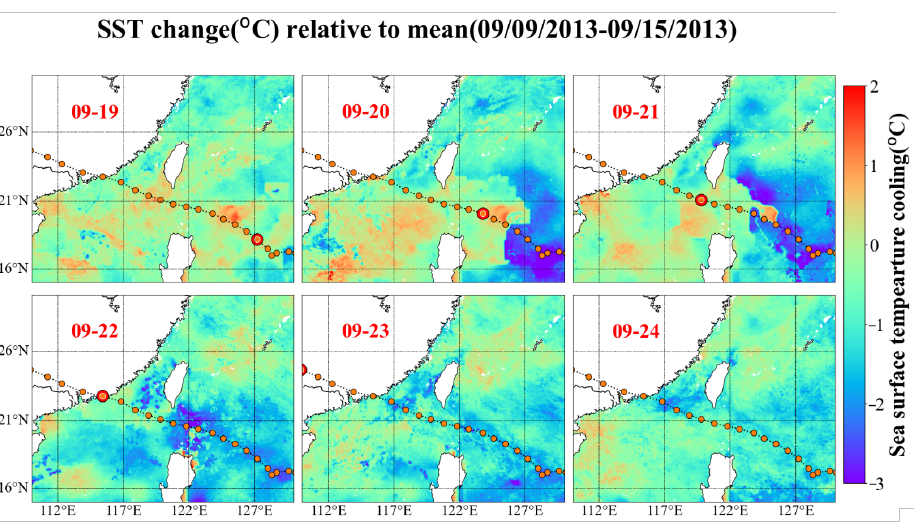
Figure 10. The daily sea surface temperature change from 19 September to 24 September relative to the mean sea surface temperature anomalies from 9–15 September during Typhoon 1319Usagi. The big circle in red is the location of the typhoon at 12:00 that